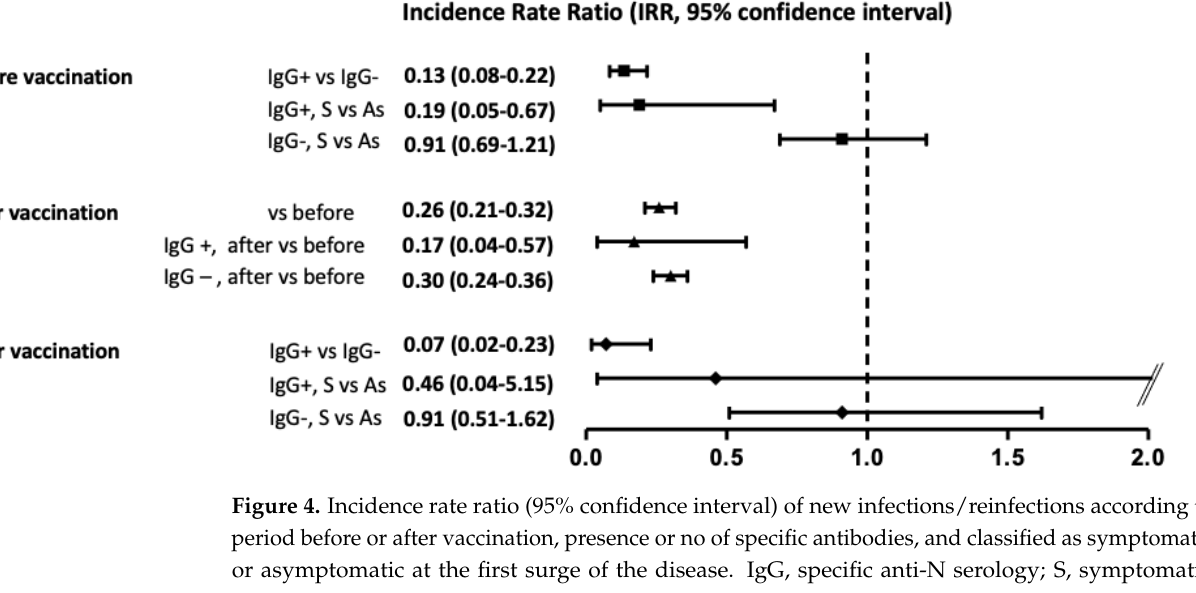
Figure 3. Incidence rates (95% confidence interval) of new infections/reinfections in function of the five different subgroups of the study (dark grey bars, before vaccination; grey bars, after vaccination). PCR, polymerase chain reaction; Serol, anti-N specific serology.